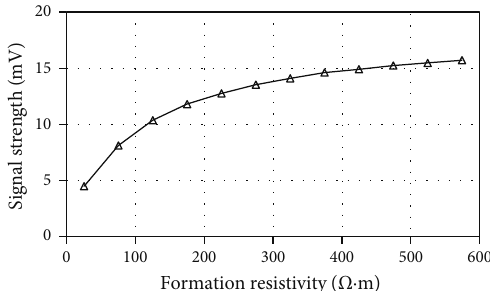
Figure 4: Relationship between received signal strength and formation